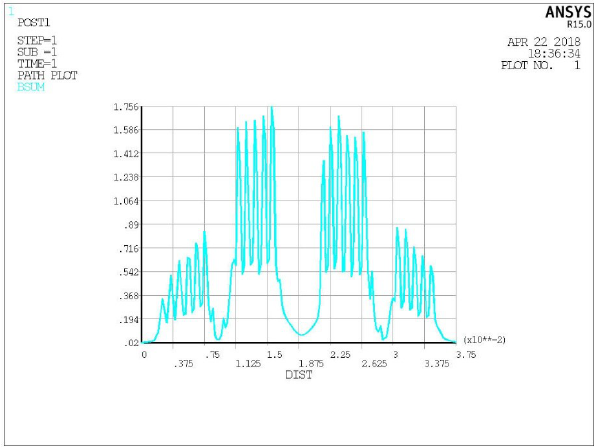
Fig. 13 Distribution of B in the seal gap between split pole shoes and shaft for the split pole shoes with optimised structure.